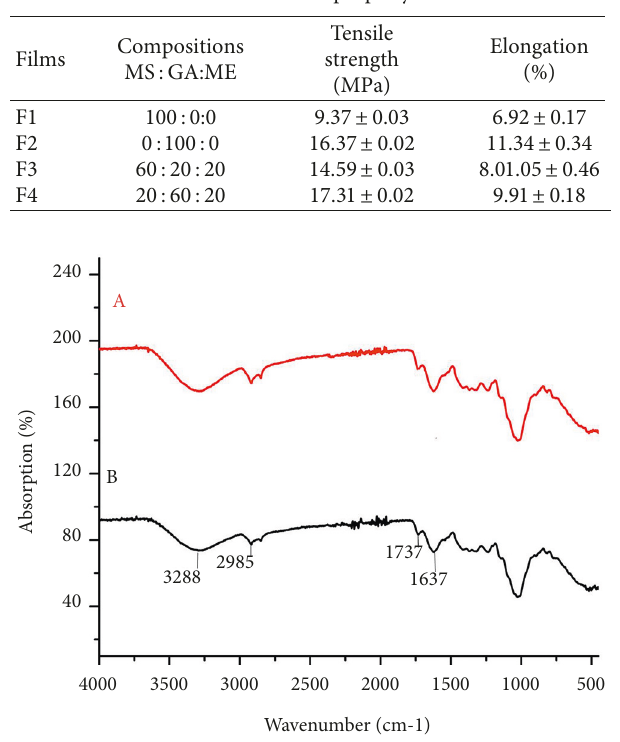
Figure 1: FTIR spectra showing (a) MS films and (b) MS films with ME and GA.